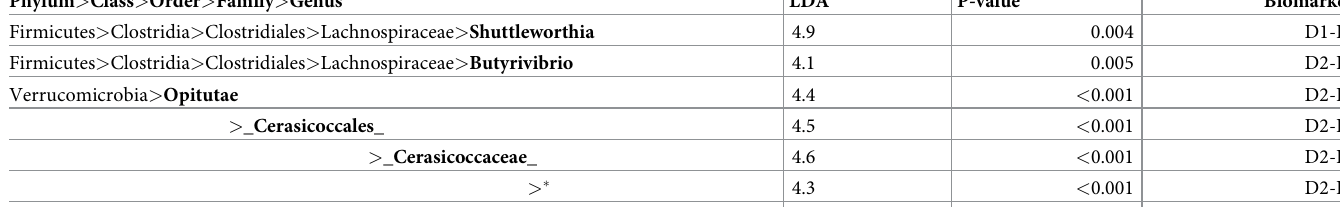
Table 1. Linear discriminate analysis effect size (LEfSe) showing significant taxa (biomarkers, in bold) in the faeces of the ponies for each sampling day (D) when ponies (n = 6) were maintained on hay (H). Phylum > Class > Order > Family > Genus LDA P-value